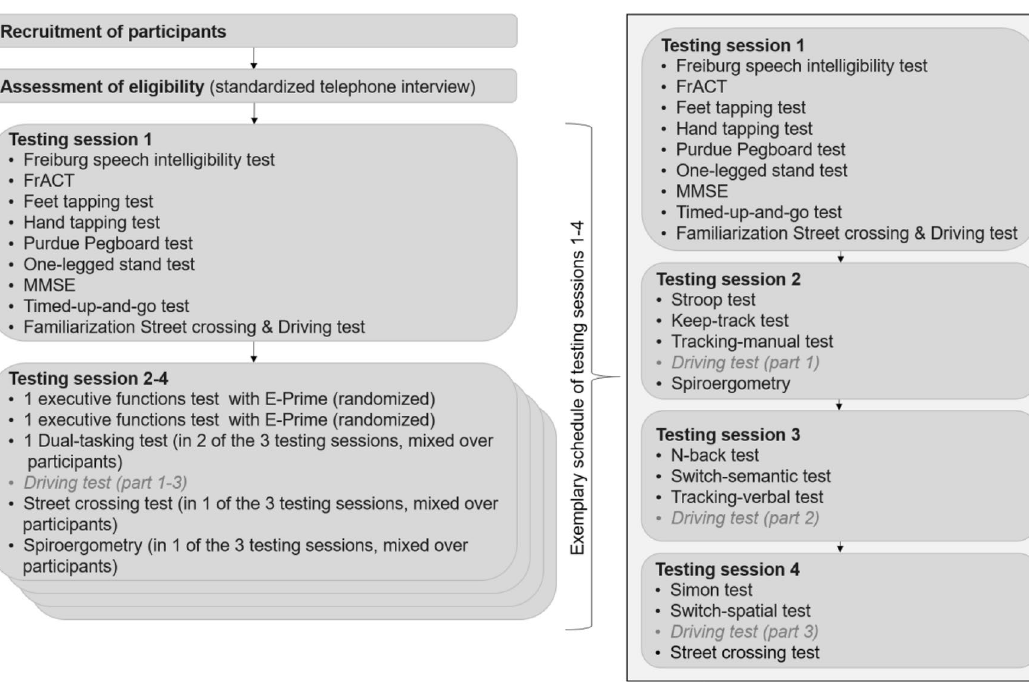
Figure 5. Study flow chart. Data of the driving test was not analyzed for this study and is therefore marked in grey and italic. FrACT = Freiburg Visual Acuity Test; MMSE = Mini Mental State